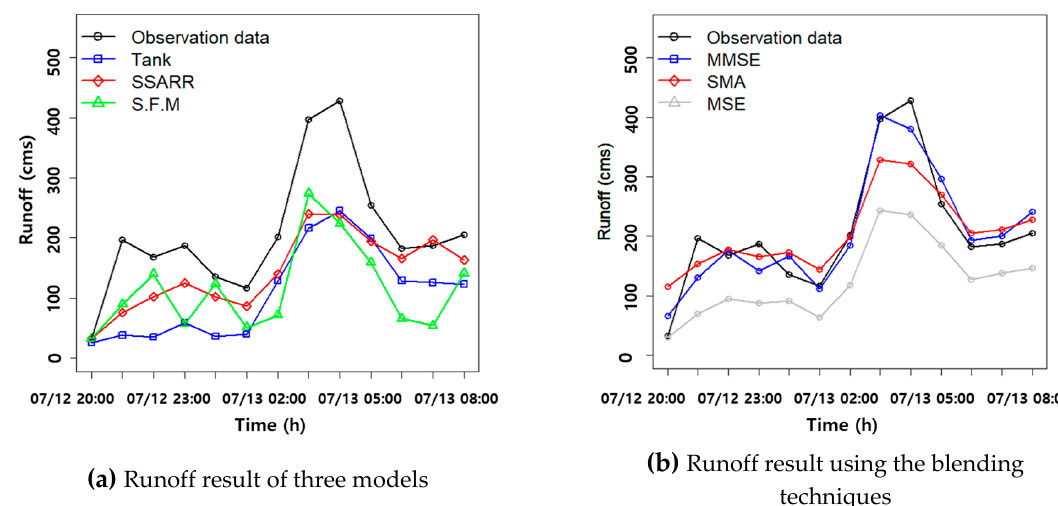
Figure 14. Runoff hydrograph using the minimum rainfall ensemble.